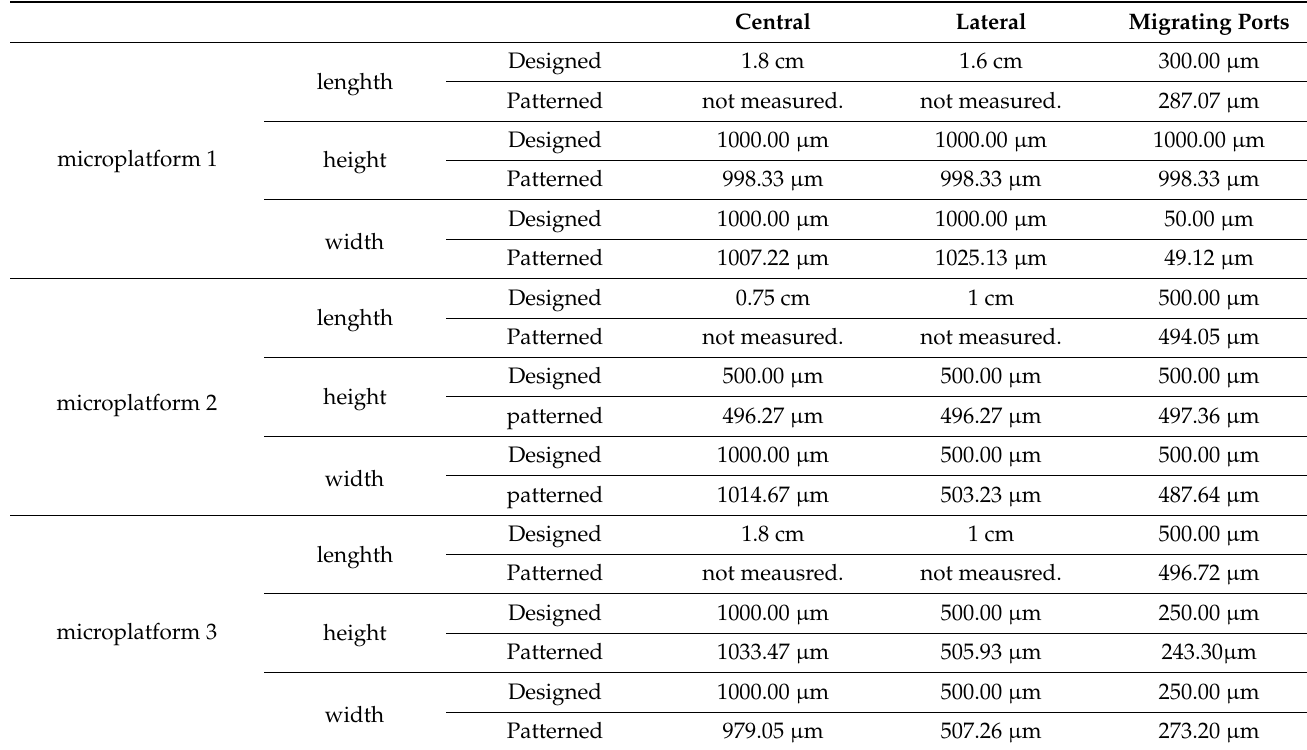
Table 1. Comparison of designed dimensions with dimensions of patterned molds. Measurements were executed with the use of 3D Laser Measuring Microscope (LEXT